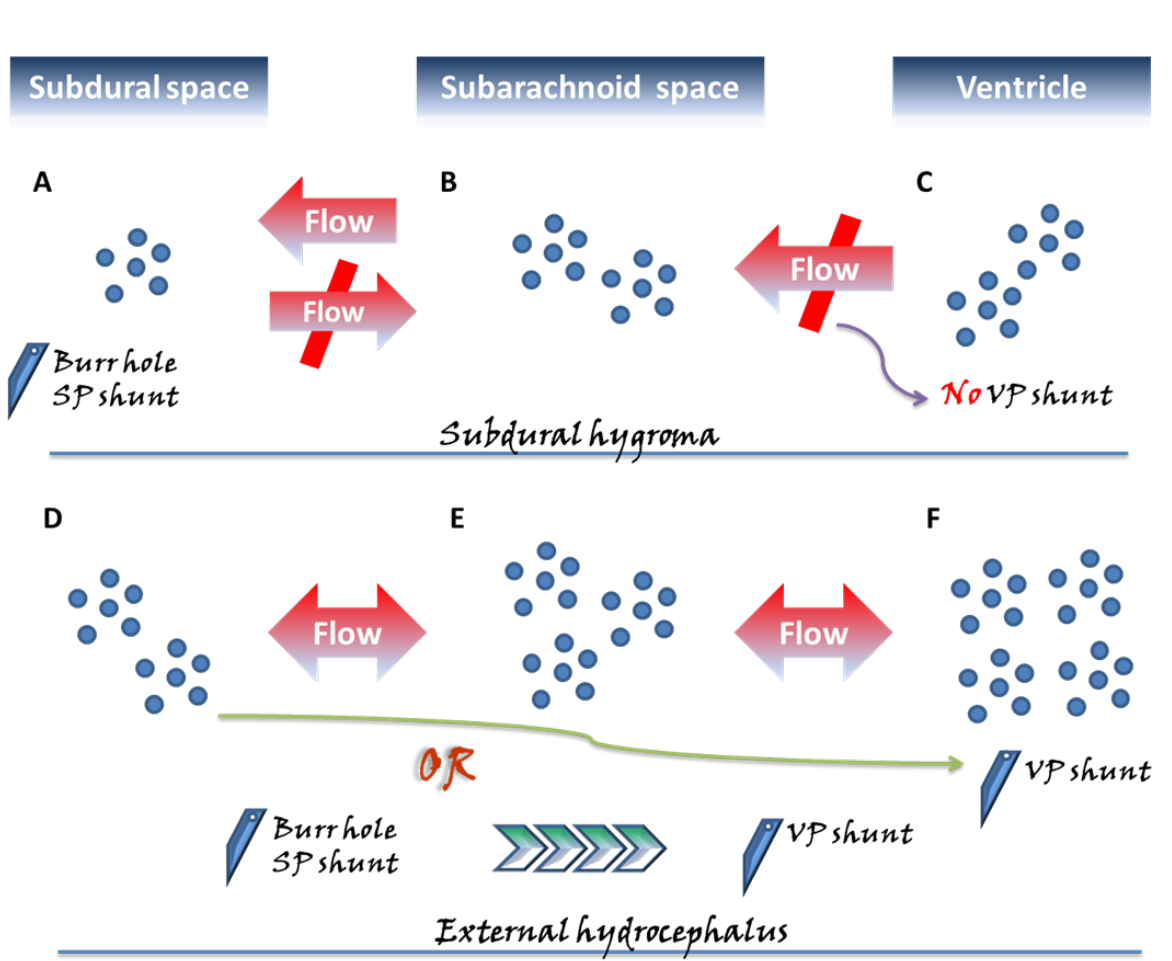
Figure 1. Two categories of subdural fluid collections deserving special attention, the subdural hygroma and external hydrocephalus, exhibit different pathogenic mechanisms and are surgically managed with different perspectives. In the subdural space, approximately three months following acute bleeding, a chronic subdural hematoma (CSDH) might emerge, characterized by a liquefied hematoma with neomembranes and which remains confined to the subdural space. In contrast to the above pathogenic mechanism derived from a single space, in the subdural hygroma ( A – C ), the flow of cerebrospinal fluid (CSF) in the subarachnoid space ( B ) further influxes unidirectionally into the subdural space ( A ) through the ruptured subarachnoid membrane. Unlike external hydrocephalus, no disturbance in CSF circulation is observed in the subdural hygroma; hence, there is no applied pressure from the ventricle ( C ). Therefore, the gradient-evoked flow of the CSF communication from ( B ) to ( A ) reaches a particular level, and then the pressures within the subdural space likely cease to increase, appearing in the one-way form, and being confined to the state of compartment pressure <15 mmHg. Moreover, in the pathological state of external hydrocephalus, more aptly denoted as subdural effusion with hydrocephalus, the pressure in the subarachnoid space ( E ) progressively builds up as a result of the disturbance in CSF caused by the hydrocephalus ( F ), driving gradient-evoked flow to gradually accumulate in this space. Afterward, in a situation similar to that of the subdural hygroma, a flow of CSF within the subarachnoid space ( E ) from the ruptured arachnoid membrane proceeds toward the subdural space ( D ). Because of the pressure caused by the hydrocephalus, the pressure gradient between the ventricle–subarachnoid–subdural space leads to a gradual gain of pressure in the subdural space. In the condition of external hydrocephalus, the pressure inside the subdural space is significantly higher, that is, approximately >15 cmH 2 O compared to subdural effusion. Based on the above-mentioned different mechanisms, in the clinical setting for patients undergoing intracranial pressure and requiring neurosurgical decompression, the use of ventriculoperitoneal (VP) shunt on subdural hygroma possibly exacerbates the